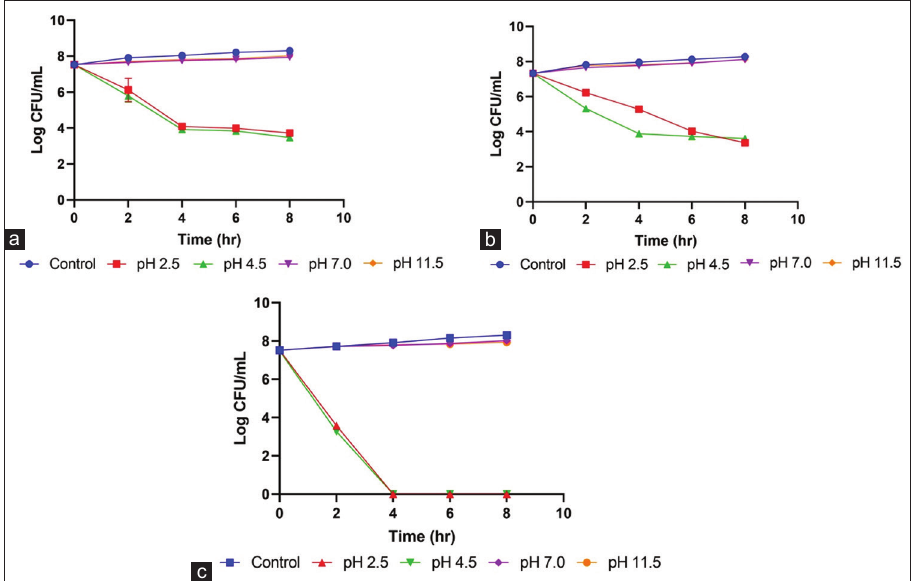
Figure-1: Antibacterial effect of different pH ionized waters on prominent Gram-positive bacterial isolated from horses wound. (a) Staphylococcus aureus , (b) Staphylococcus pseudintermedius , (c) Staphylococcus intermedius .